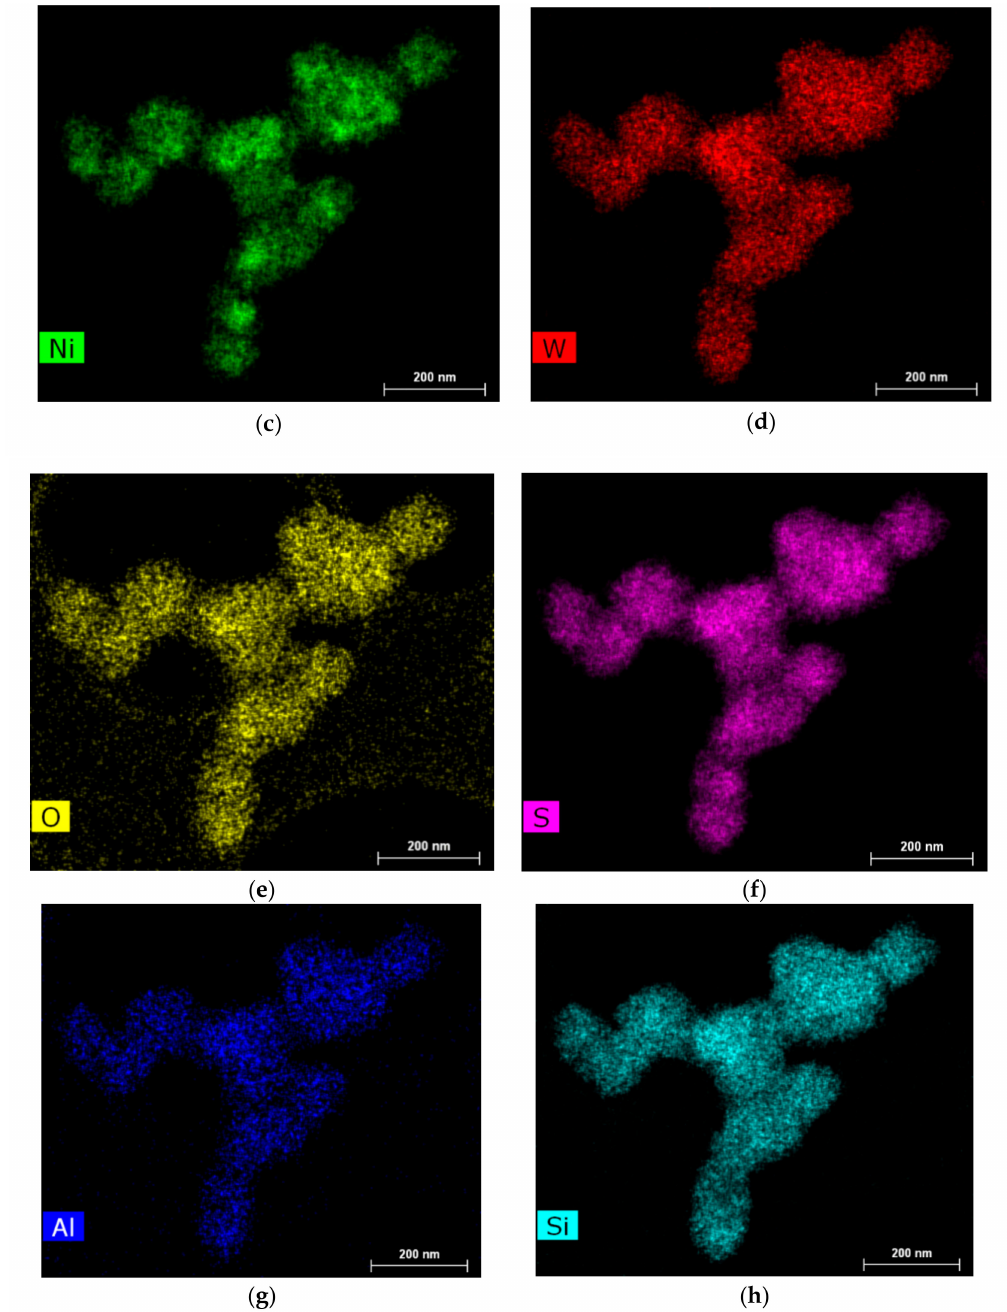
Figure 6. ( a ) TEM micrograph and distribution maps of NiWS-HY(0.5%) elements ( b ) Ni-W, ( c ) Ni, ( d ) W, ( e ) O, ( f ) S, ( g ) Al, ( h ) Si obtained in situ in standard